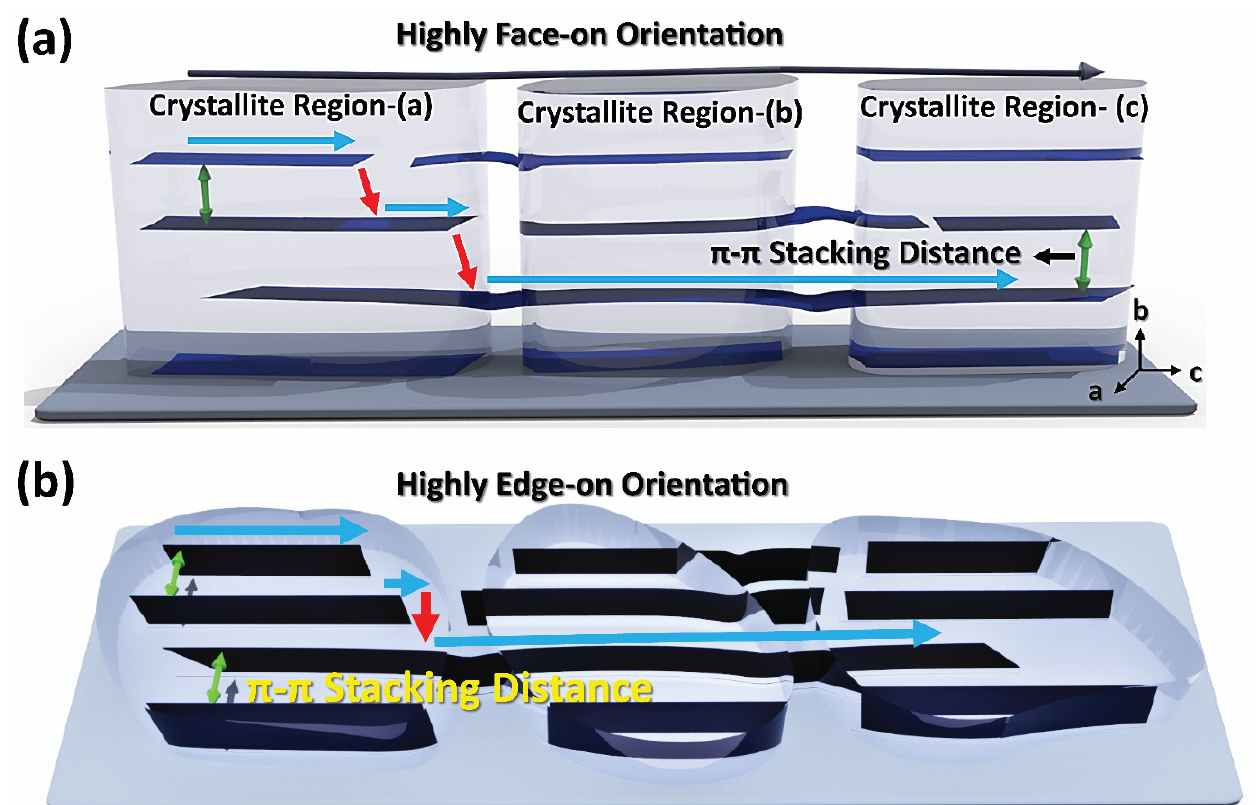
Figure 16. Schematic of the current transport mechanism in conjugated conducting/semiconducting polymers with ( a ) a highly face-on orientation [12] and ( b ) a highly edge-on orientation [1]. The blue and red arrows indicate the intra- and inter-chain charge transport direction. ( a ) Reproduced with permission [12]. Copyright 2019, Science. ( b ) Reproduced with permission [1]. Copyright 2020, Elsevier.